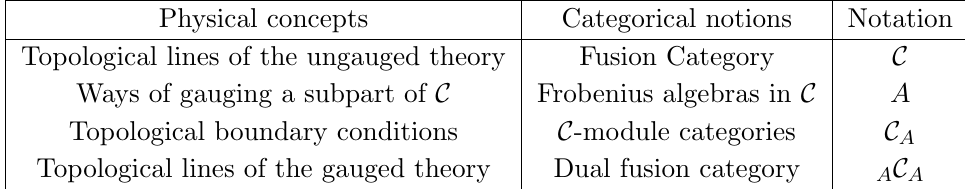
Table 2. Fusion category theory notions and the corresponding physical